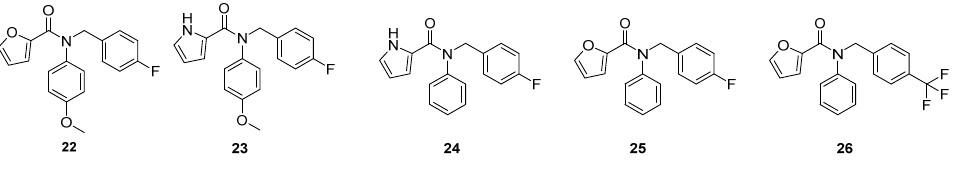
Figure 13. Chemical structures of compounds 22 – 26